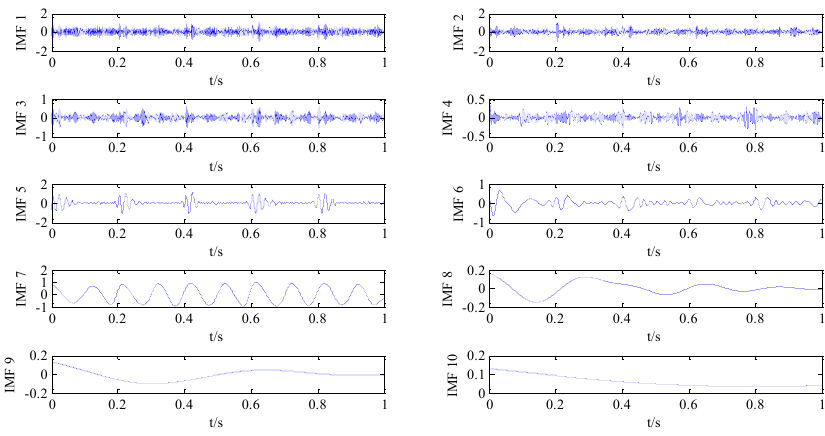
Figure 7. The intrinsic mode functions (IMF S ) of simulation signal.